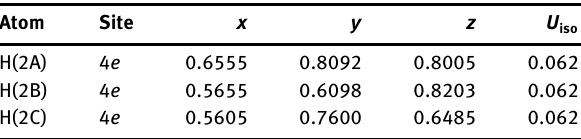
Table 2: Fractional atomic coordinates and isotropic or equivalent isotropic displacement parameters (Å 2